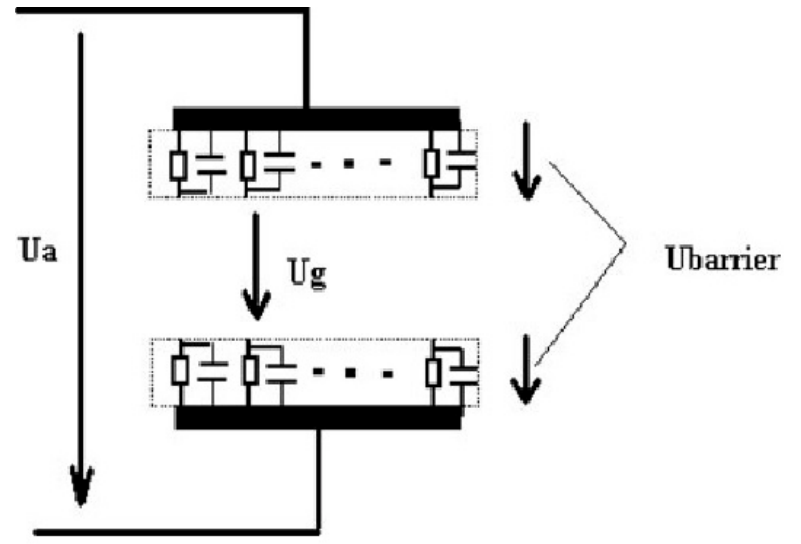
Figure 4. Electrical model of the RBD [24].